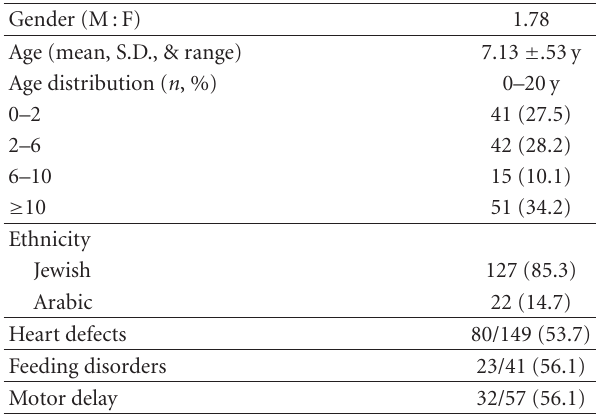
Table 1: Demographic and clinical characteristics of